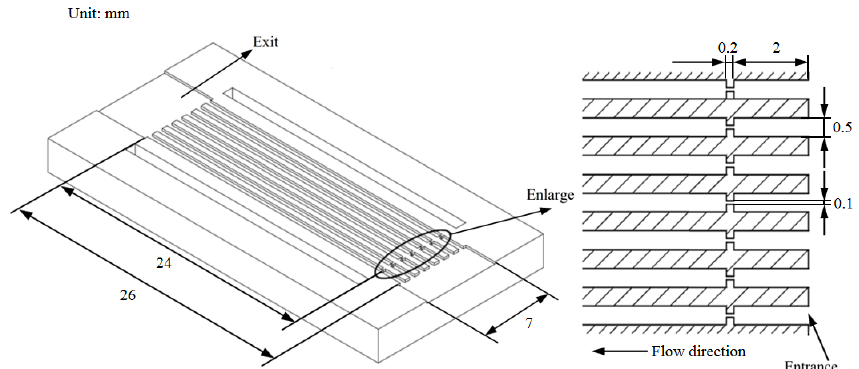
Figure 1. The structure of the micro-channels.